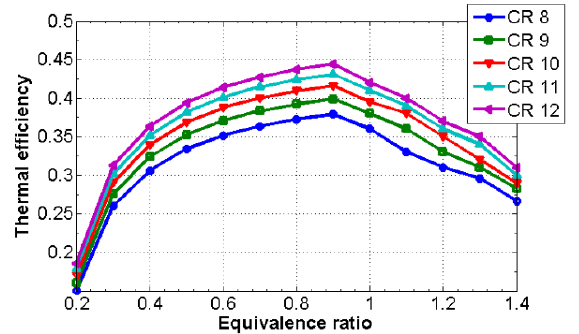
Figure 4. Variation of thermal efficiency with the fuel-air equivalence ratio at various compression ratios.